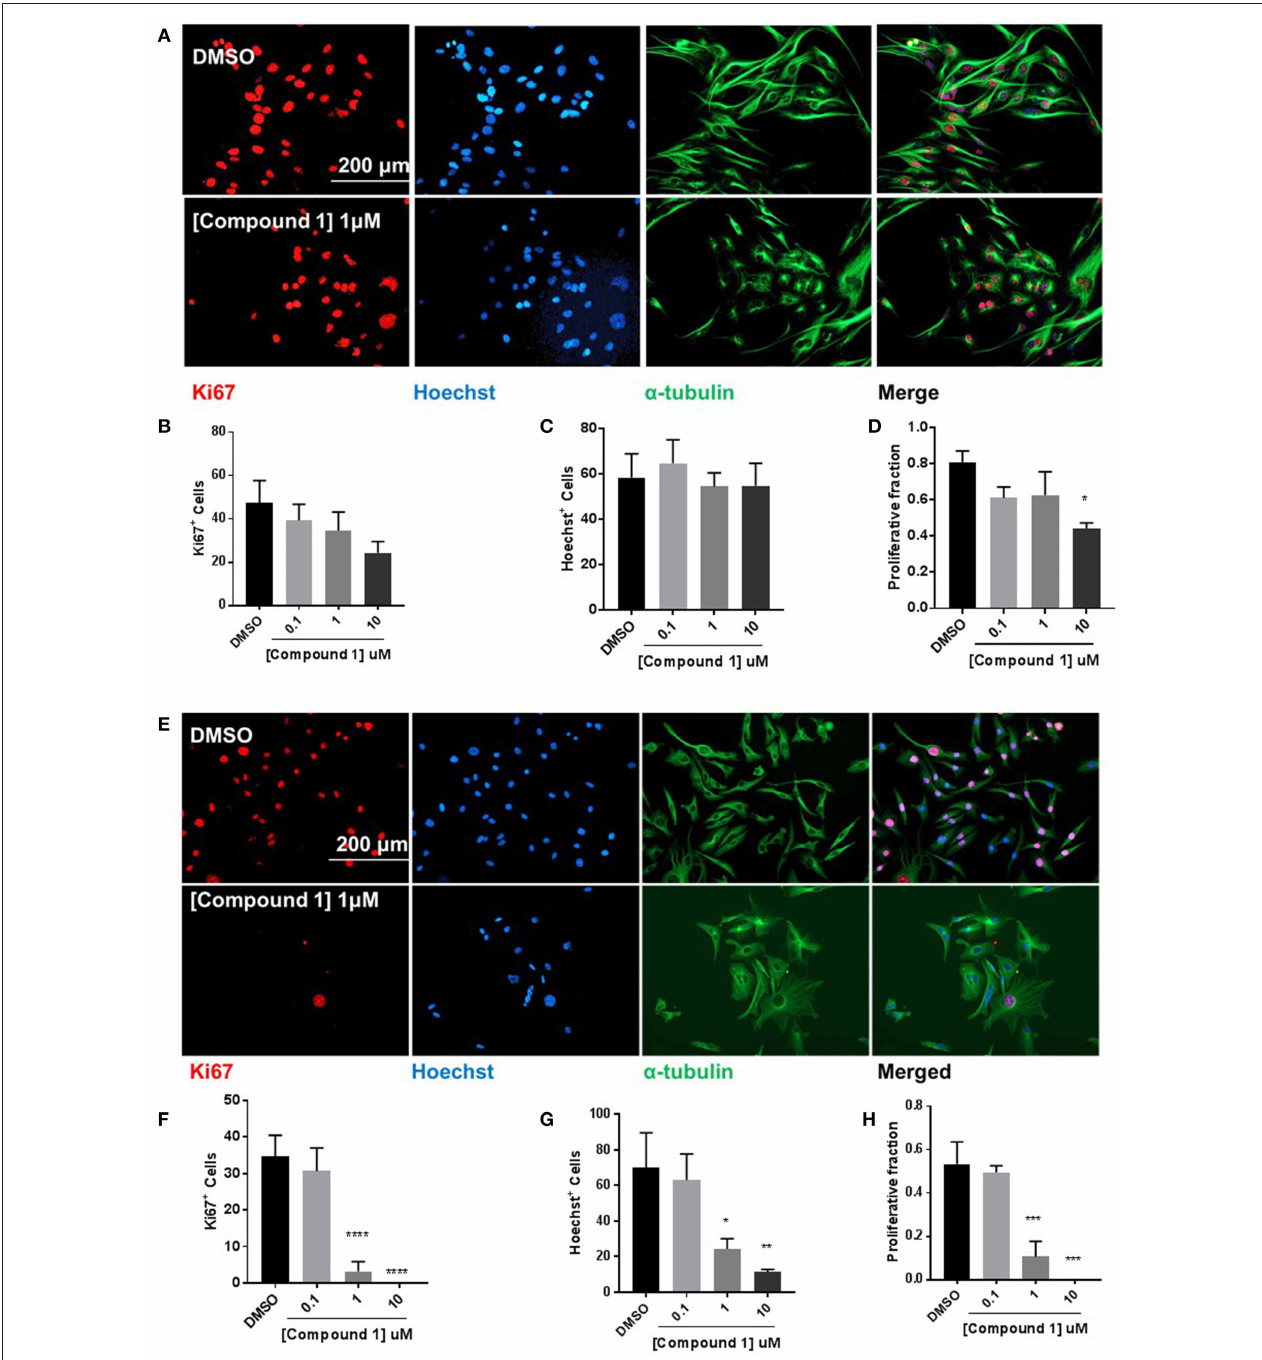
FIGURE 6 | Compound 1 inhibits cell proliferation in BT-549 and TAMR MCF-7 cells. (A) Immunofluorescence staining of Ki67, Hoechst, and α -tubulin in BT-549 cells treated with DMSO or compound 1 (1 µ M), for 72h, scale bar 200 µ m. (B) Ki67 + cells decreased with increasing concentrations (0.1, 1, 10 µ M) of compound 1 . (C) Decrease in Hoechst + cells with increasing concentrations (0.1, 1, 10 µ M) of compound 1 . (D) The proliferative fraction calculated as the ratio of Ki67 + cells to Hoechst + cells at increasing concentrations (0.1, 1, 10 µ M) of compound 1 . Data represent ± SEM of three different experiments. * p < 0.05 vs. control group determined by one-way ANOVA with the Bonferroni post hoc test. (E) Immunofluorescence staining of Ki67, Hoechst, and α -tubulin in TAMR MCF-7 cells treated with DMSO or compound 1 (1 µ M), for 72h, scale bar 200 µ m. (F) Ki67 + cells decreased with increasing concentrations (0.1, 1, 10 µ M) of compound 1 . (G) Decrease in Hoechst + cells with increasing concentrations (0.1, 1, 10 µ M) of compound 1 . (TAMR MCF-7 cells) (H) The proliferative fraction calculated as the ratio of Ki67 + cells to Hoechst + cells at increasing concentrations (0.1, 1, 10 µ M) of compound 1 (TAMR MCF-7 cells). Data represent ± SEM of three different experiments. * p < 0.05; ** p < 0.01; *** p < 0.001; **** p < 0.0001 vs. control group determined by one-way ANOVA with the Bonferroni post hoc test.